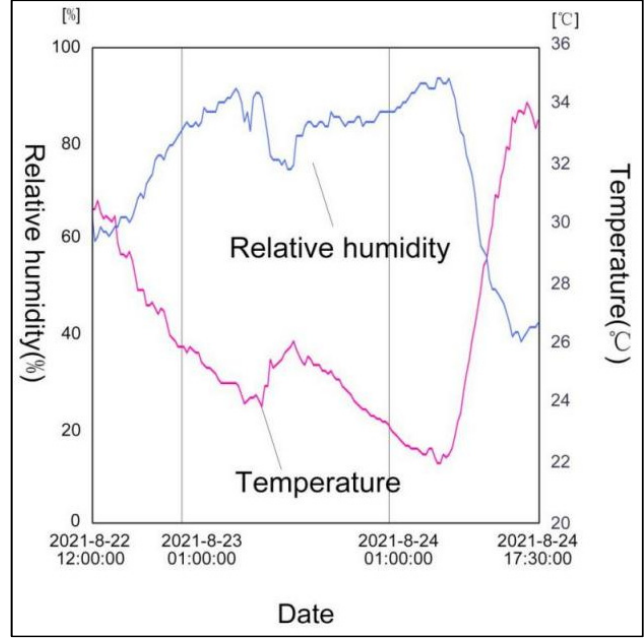
Figure 14. Outdoor environmental parameters in summer.